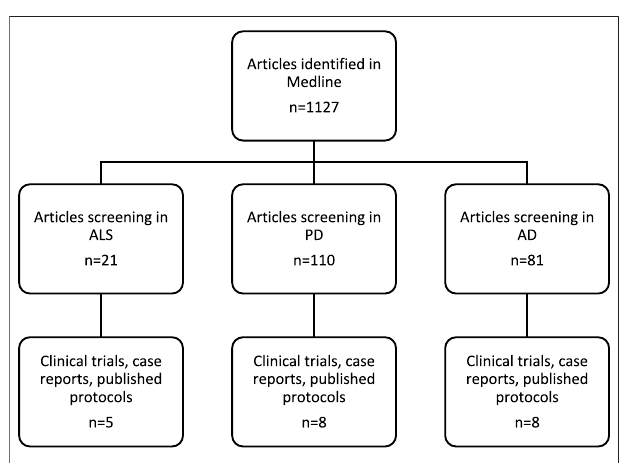
FIGURE 1 | Flow chart of the included clinical